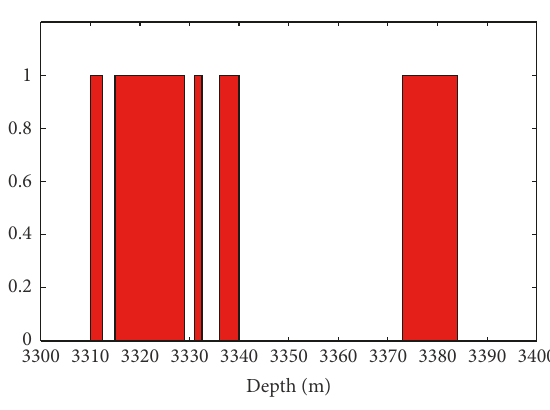
Figure 4: LS-SVM recognition